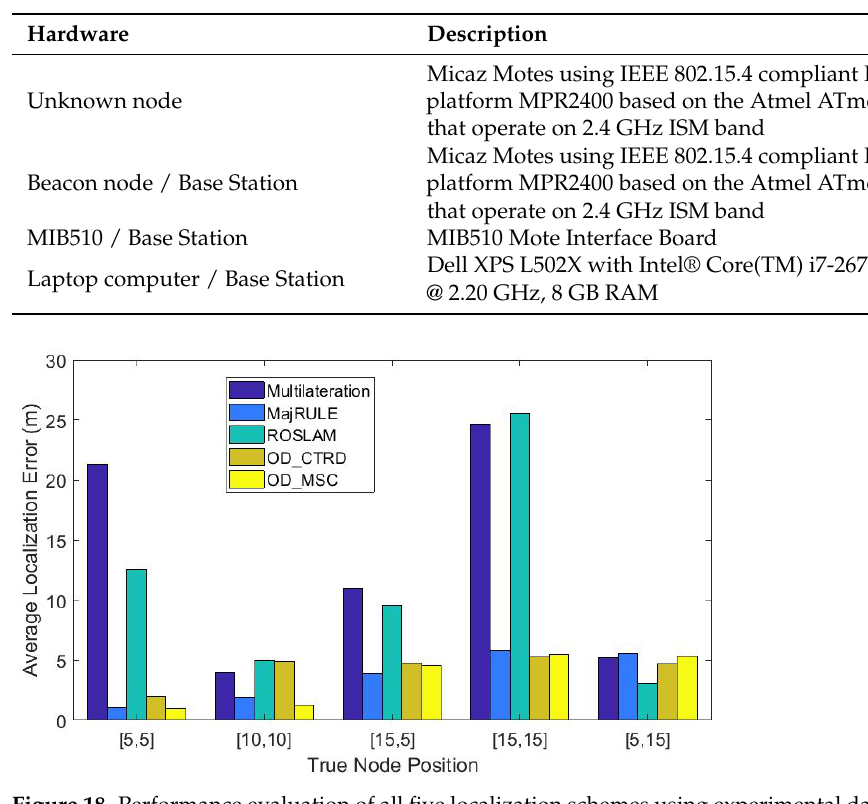
Table 2. Hardware description [36].